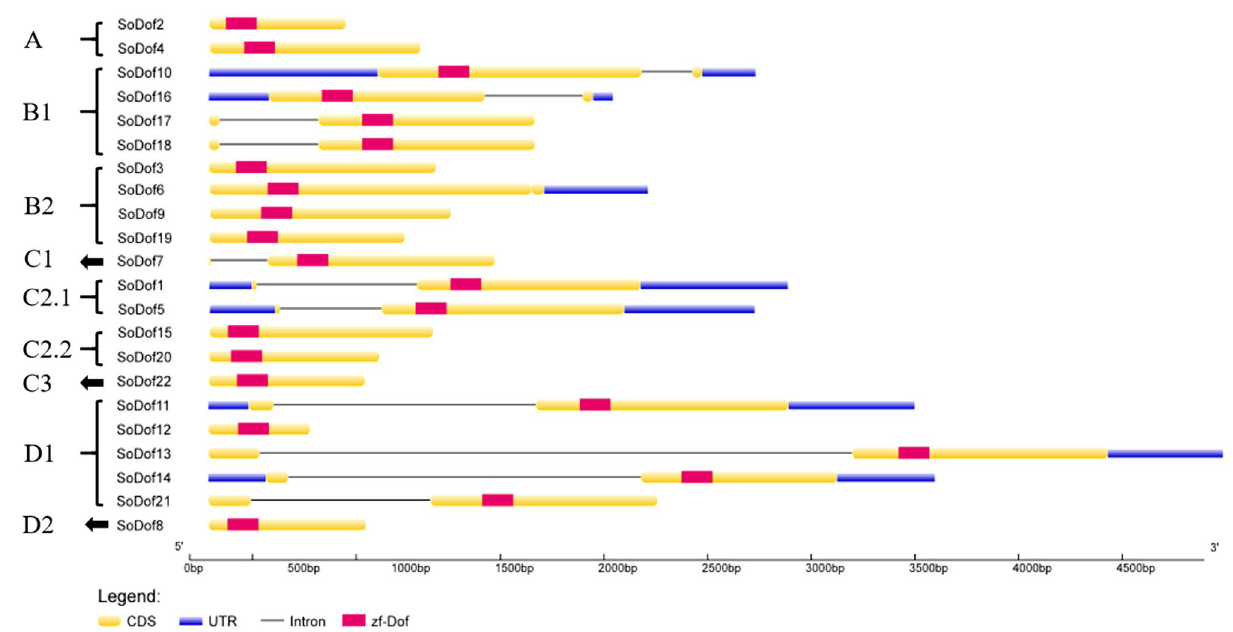
Figure 4. The exon–intron structure of Dof genes in Spinach: CDS (yellow), UTR (blue), Intron (black line) and zf-Dof region (pink). SoDof6 contains one intron which is too short to recognize in this figure resolution. Figure was made by the Gene Structure Display Server (http:// gsds. cbi. pku. edu.